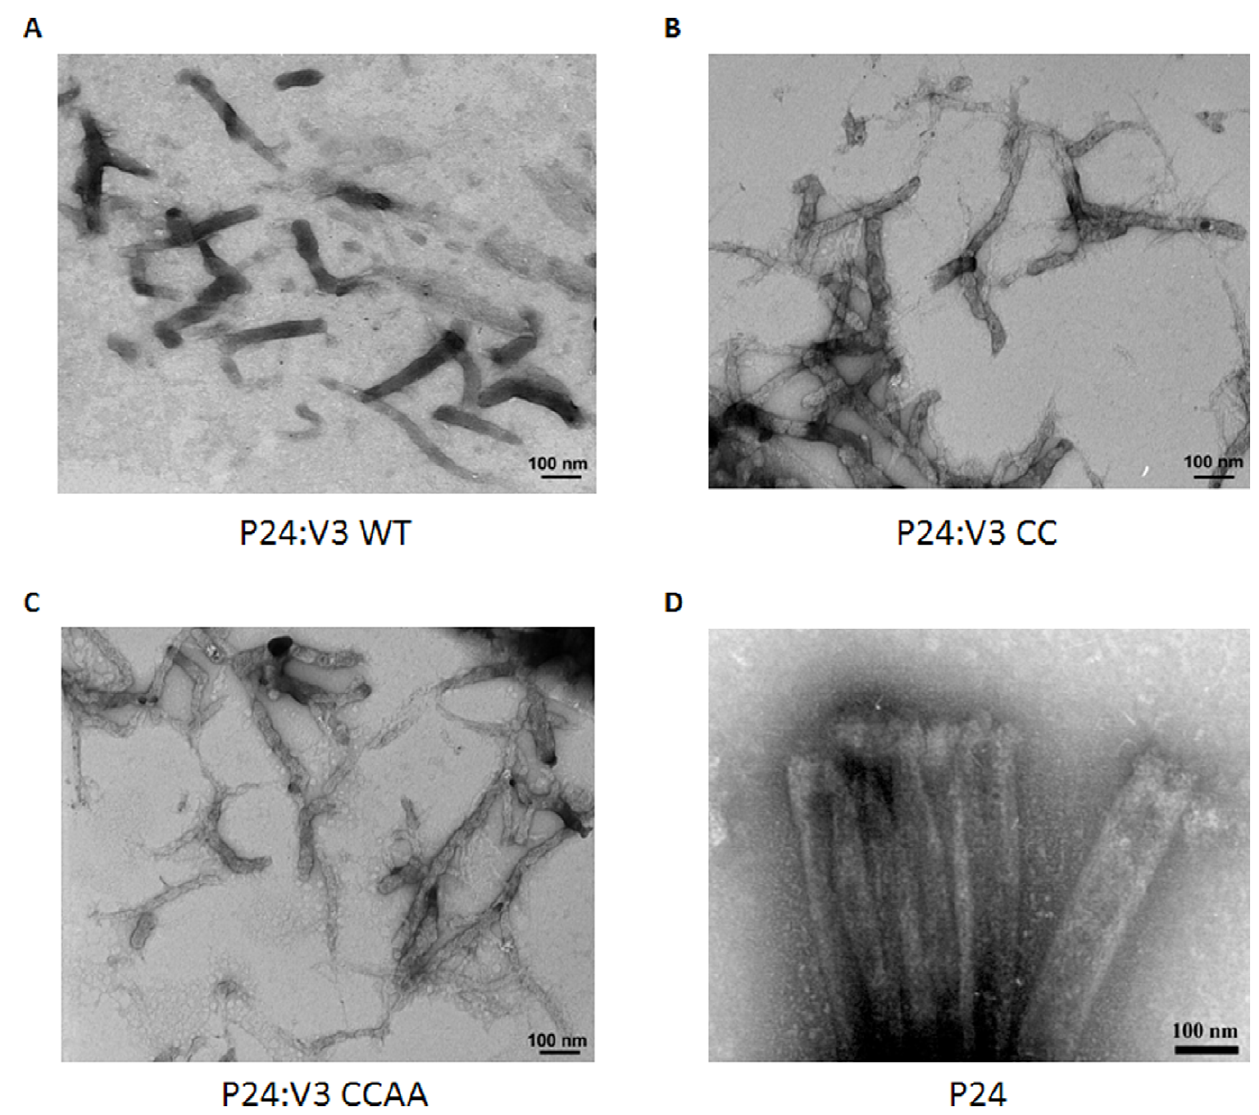
Figure 7. Electron microscope analysis. P24:V3 chimeric proteins assembled in vitro were stained with uranyl acetate, and visualized via transmission electron microscopy. They form cylinder structures similar to the ones formed by the p24. The scale bars are indicated.